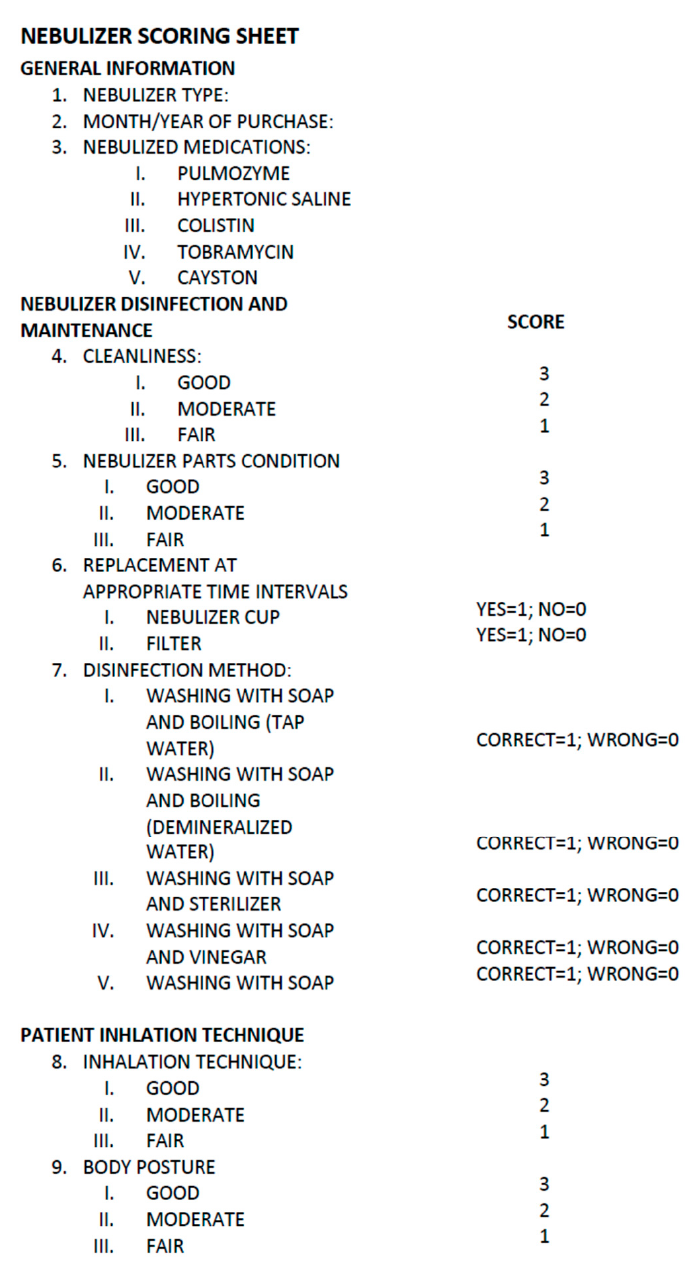
Figure A1. Scoring sheet Caption.